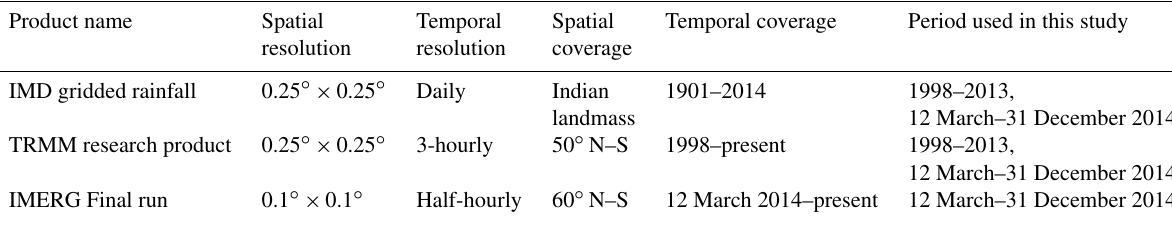
Table 1. Summary of the precipitation datasets used.